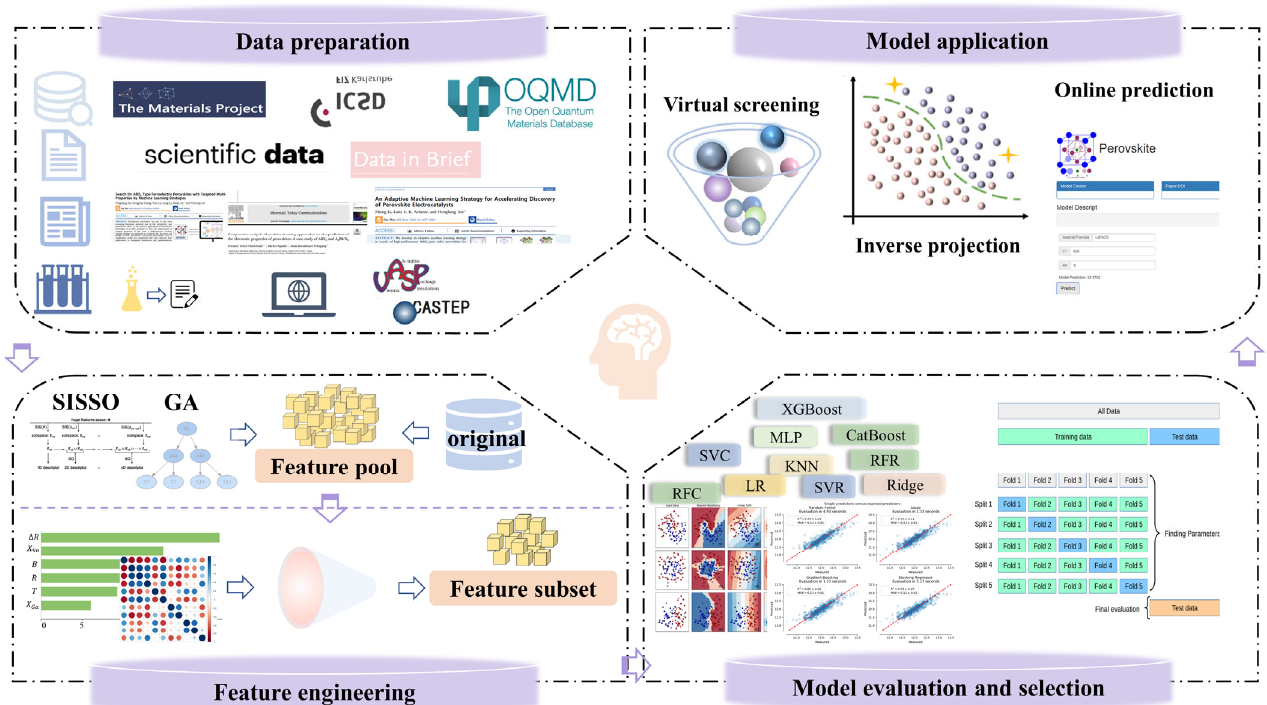
Figure 2. The general work fl ow of materials ML.